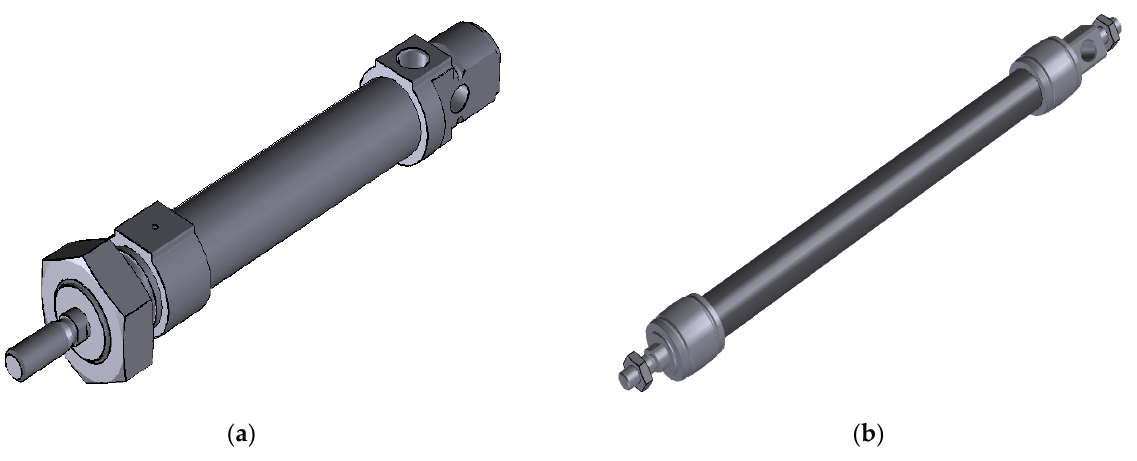
Figure 2. Studied pneumatic motors: ( a ) Single-acting cylinder (ESNU) [34]; ( b ) Pneumatic muscle (DMSP) [35]. (DMSP) [35].